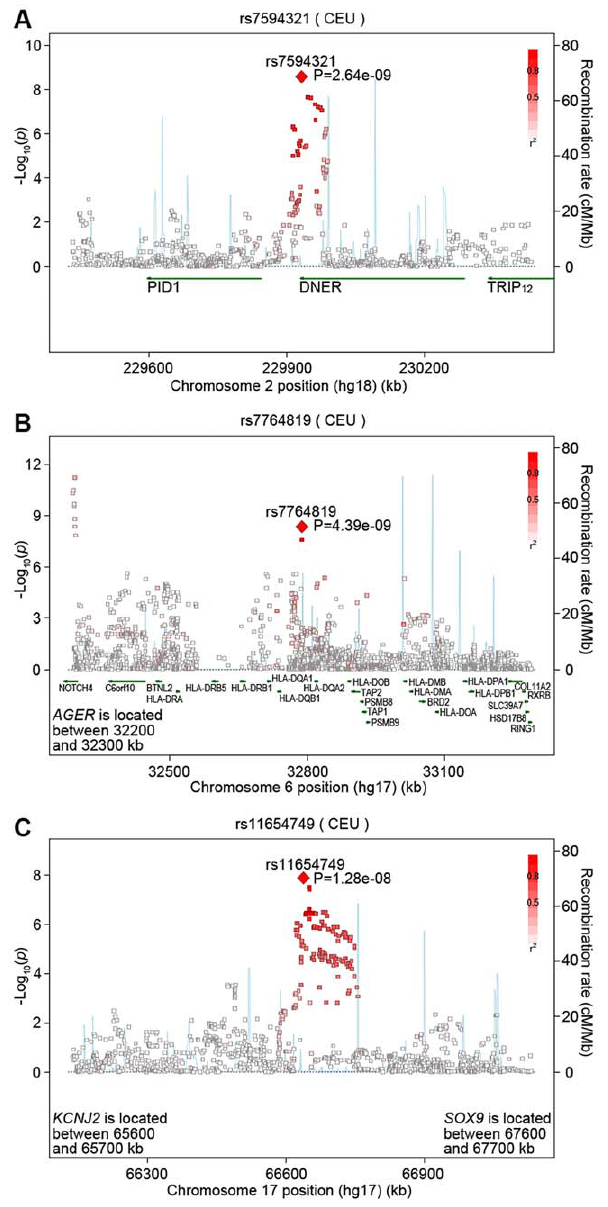
Figure 2. Regional association plots of novel loci implicated for pulmonary function. Three novel loci contained SNPs associated with FEV 1 /FVC or FEV 1 at the standard genome-wide significance threshold ( P , 5 6 10 2 8 ) in joint meta-analyses of SNP and SNP-by- smoking interaction. SNPs are shown within 500 kb of the most significant SNPs on chromosomes (A) 2q36.3 associated with FEV 1 /FVC, (B) 6p21.32 associated with FEV 1 /FVC, and (C) 17q24.3 associated with FEV 1 . Pairwise r 2 values were based on the HapMap CEU population, and progressively darker shades of red indicate higher r 2 values. Estimated recombination rates from HapMap are shown as background